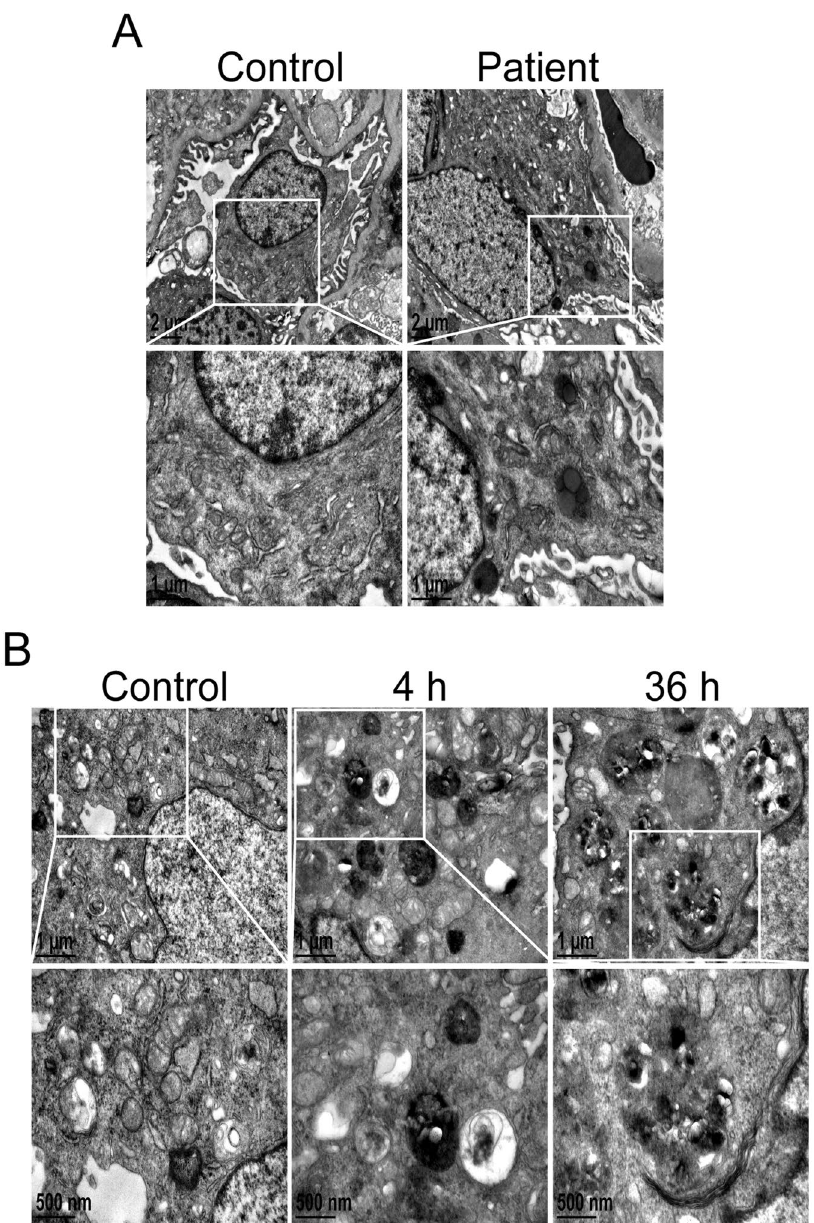
Figure 10. Ultrastructural images of lysosomes and autophagic vacuoles in podocytes from patients with idiopathic membranous nephropathy (IMN) and zymosan activation serum (ZAS)-induced C5b-9 membrane attack models. Representative electron microscope images showing impaired lysosomes as dark irregular structures in podocytes of kidney biopsy specimens from patients with IMN ( A ), and in podocytes after exposure to ZAS at 4 h, as well as lysosomes engulfed by autophagic vacuoles at 36 h ( B